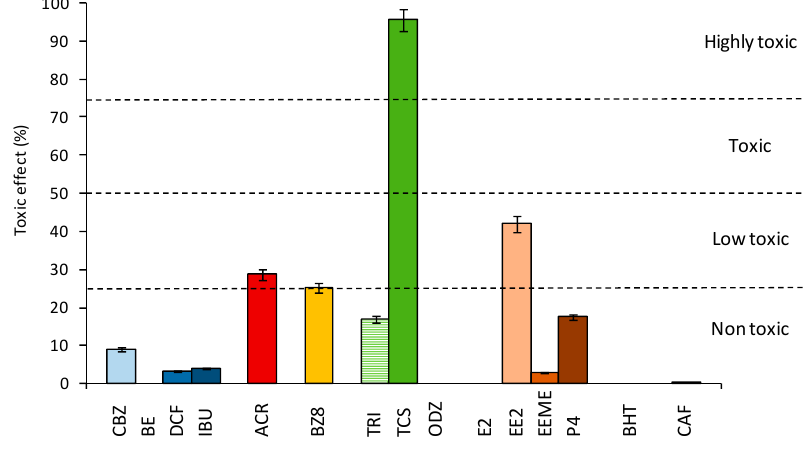
Figure 18. Toxicity of micropollutant water solutions.